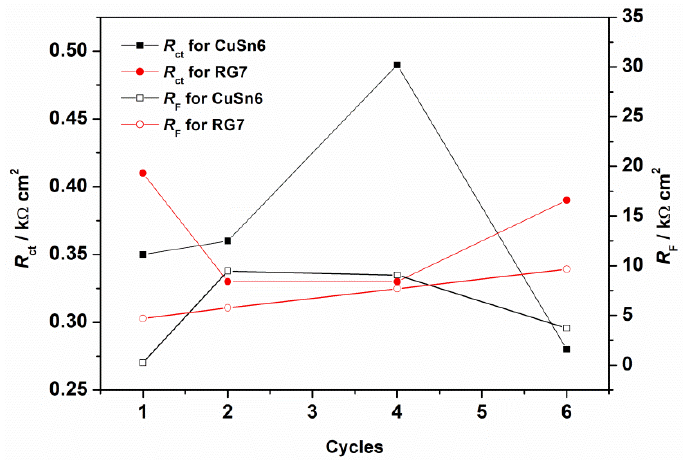
Figure 6. Evolution of charge transfer resistance ( R ct ) and reactive patina resistance ( R F ) with number of wetting cycles.